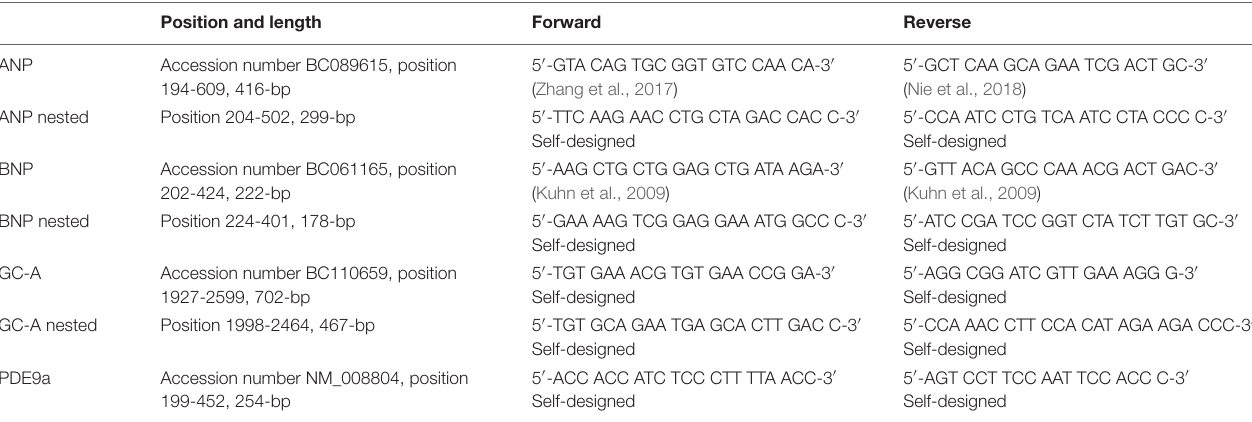
FIGURE 2 | Auditory brainstem responses (ABRs) in GC-A WT and KO mice over age. (A,B) Hearing thresholds of WT and GC-A KO littermates assessed from auditory brainstem response (ABR) potentials in response to low-frequency-containing (click), high-frequency containing (noise burst), and pure-tone frequency-specific auditory stimuli. (A) Click-evoked ABR thresholds were not affected in young GC-A KO animals [green, unpaired two-tailed student’s t -test: t (30) = 0.9870, P = 0.3315, n = 8/16 mice/ears each], but elevated in middle-aged [blue, unpaired two-tailed student’s t -test: t (100) = 2.125, P = 0.0361, WT n = 27/54 mice/ears; KO n = 48/24 mice/ears] and old [red, unpaired two-tailed student’s t -test: t (47) = 2.350, P = 0.0230, WT n = 14/28 mice/ears; KO n = 11/21 mice/ears] GC-A KOs compared to WTs. Also, noise-burst evoked ABR thresholds were elevated in middle-aged GC-A KOs [blue, unpaired two-tailed student’s t -test: t (100) = 2.890, P = 0.0047, WT n = 27/54 mice/ears; KO n = 24/48 mice/ears]. Young and old animals did not show differences in noise-burst evoked ABR thresholds [young: unpaired two-tailed student’s t -test: t (30) = 0.8649, P = 0.3940, n = 8/16 mice/ears each; old: unpaired two-tailed student’s t -test: t (47) = 1.648, P = 0.1509, WT n = 14/28 mice/ears; KO n = 10/21 mice/ears]. (B) With pure-tone frequency-specific stimuli in the range between 2 and 32 kHz, middle-aged GC-A KOs (blue) had increased ABR thresholds compared to WTs [two-way ANOVA: F (1,8) = 26.54, P < 0.0001, WT n = 27/27 mice/ears; KO n = 23/23 mice/ears]. Young and old animals did not show differences [young: two-way ANOVA: F (1,126) = 0.00, P = 0.9781, n = 8/8 mice/ears each; old: two-way ANOVA: F (1,142) = 1.43 P = 0.2235, WT n = 14/14 mice/ears; KO n = 10/10 mice/ears]. Thr n.d. = Threshold not detectable. Mean ± SEM. ∗ P < 0.05; ∗∗ P < 0.01; ∗∗∗ P < 0.001. TABLE 1 | Primer sequences and information used for